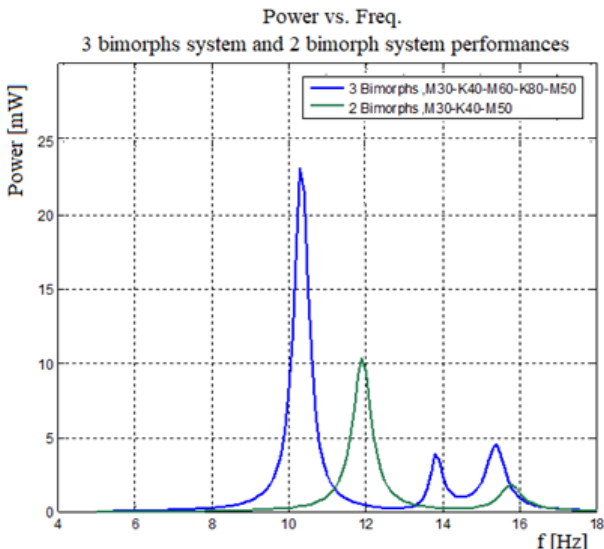
Figure 19. Generated power vs. frequency—three bimorphs and two bimorphs